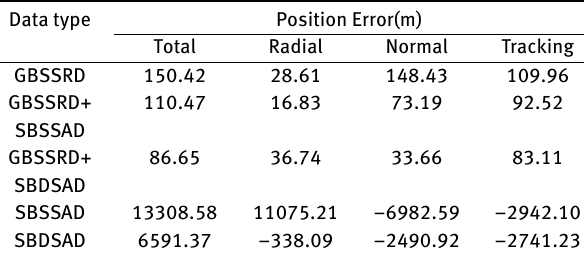
Table 3. The accuracy of orbit determination using short arc